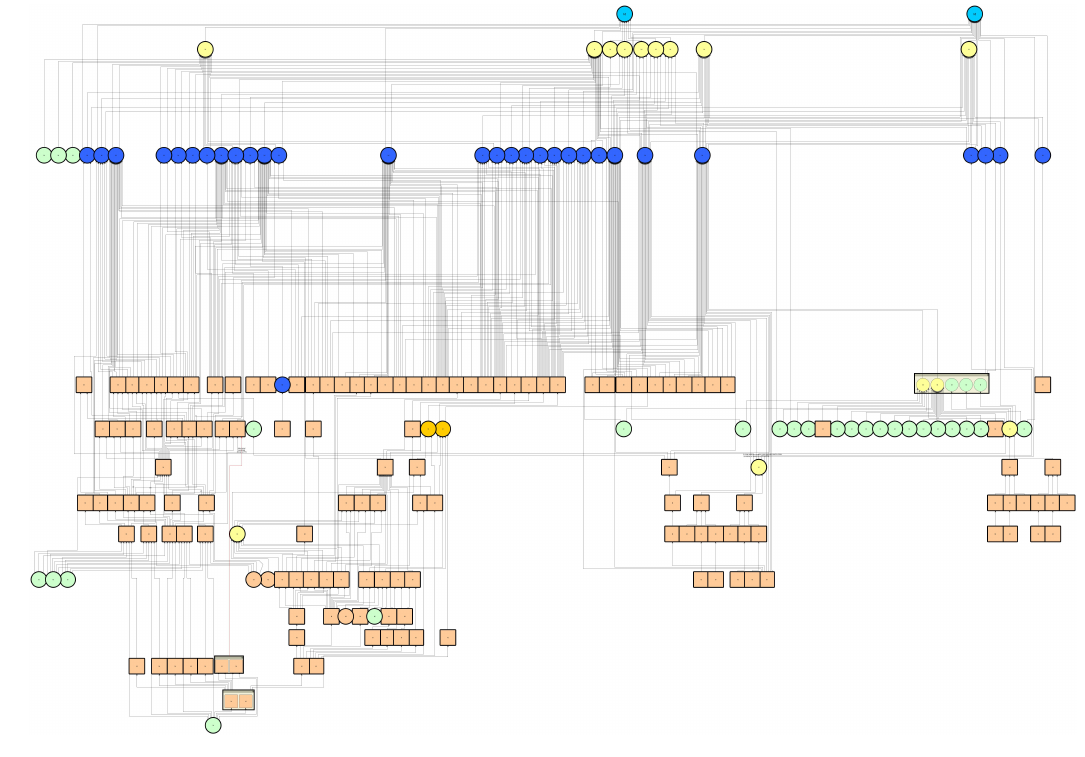
Figure 6. View of the operator cyberspace.